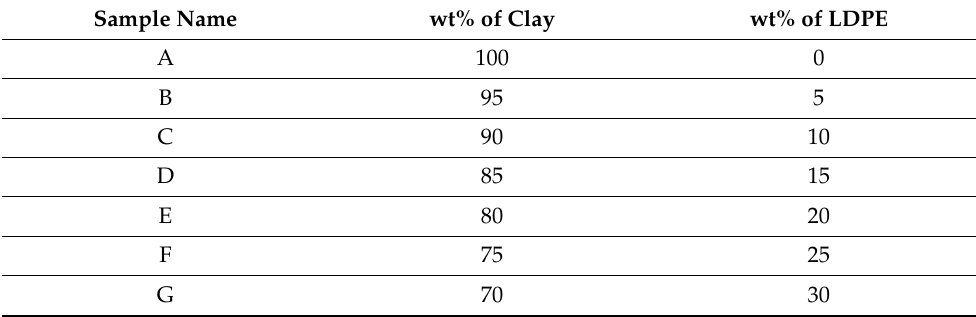
Figure 1. Brief Illustration of LDPE recycling process and fabricated clay-polyethylene composites with different concentra- tion of recycled LDPE. Table 1. Mixing proportion of clay and LDPE.